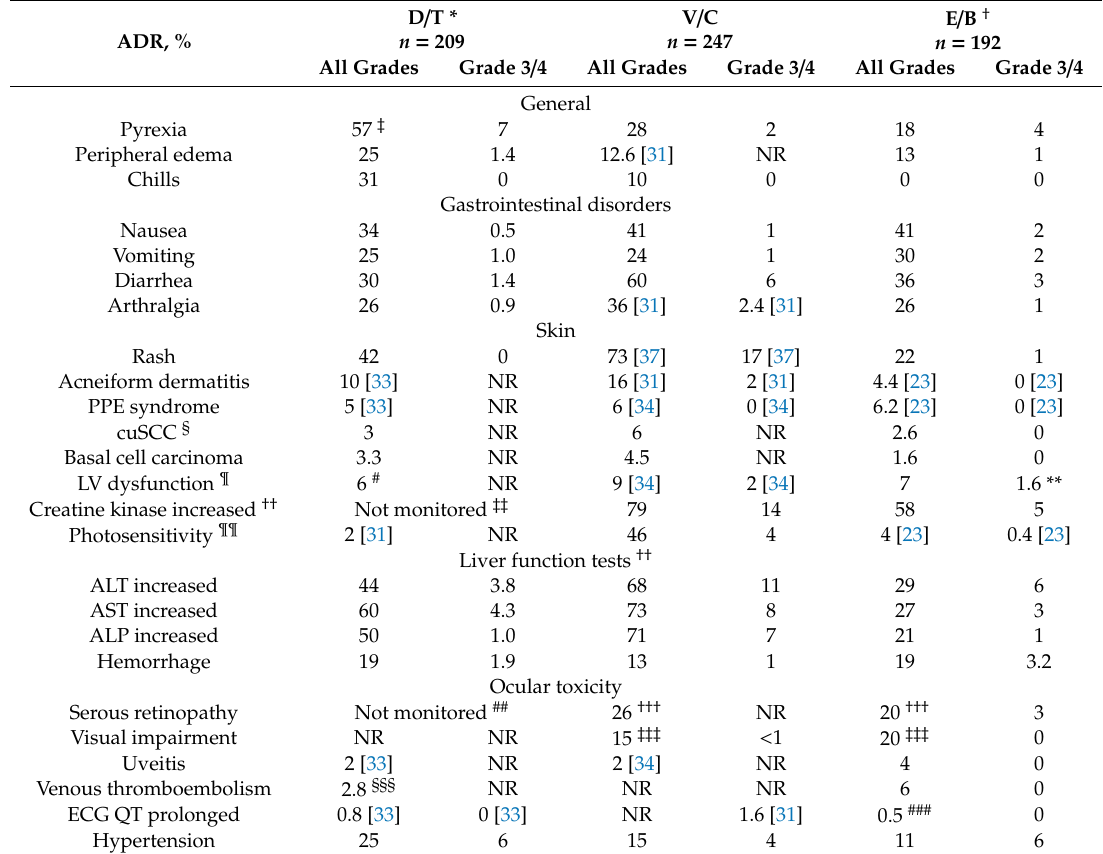
Table 4. Select adverse drug reactions, warnings, and